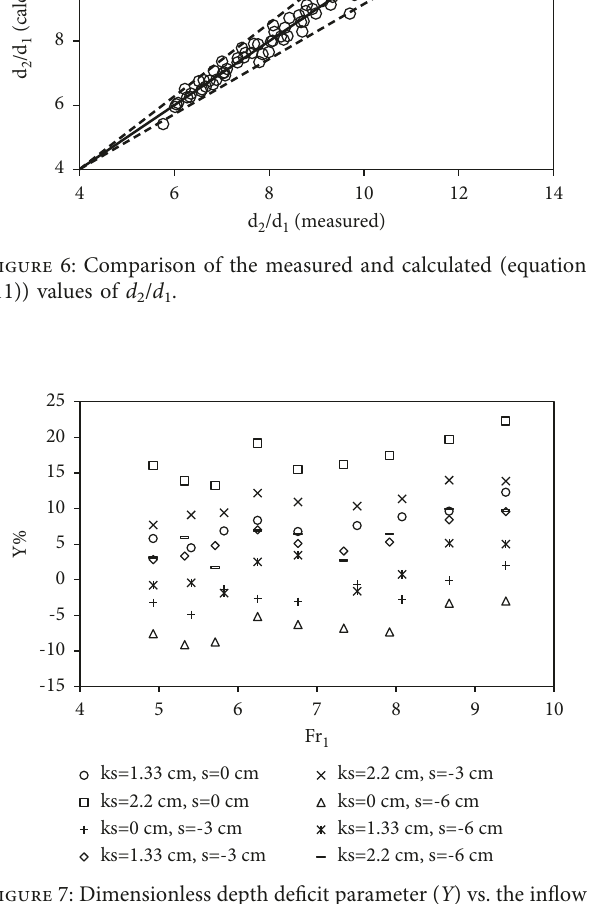
Figure 7: Dimensionless depth deficit parameter ( Y ) vs. the inflow Froude number.